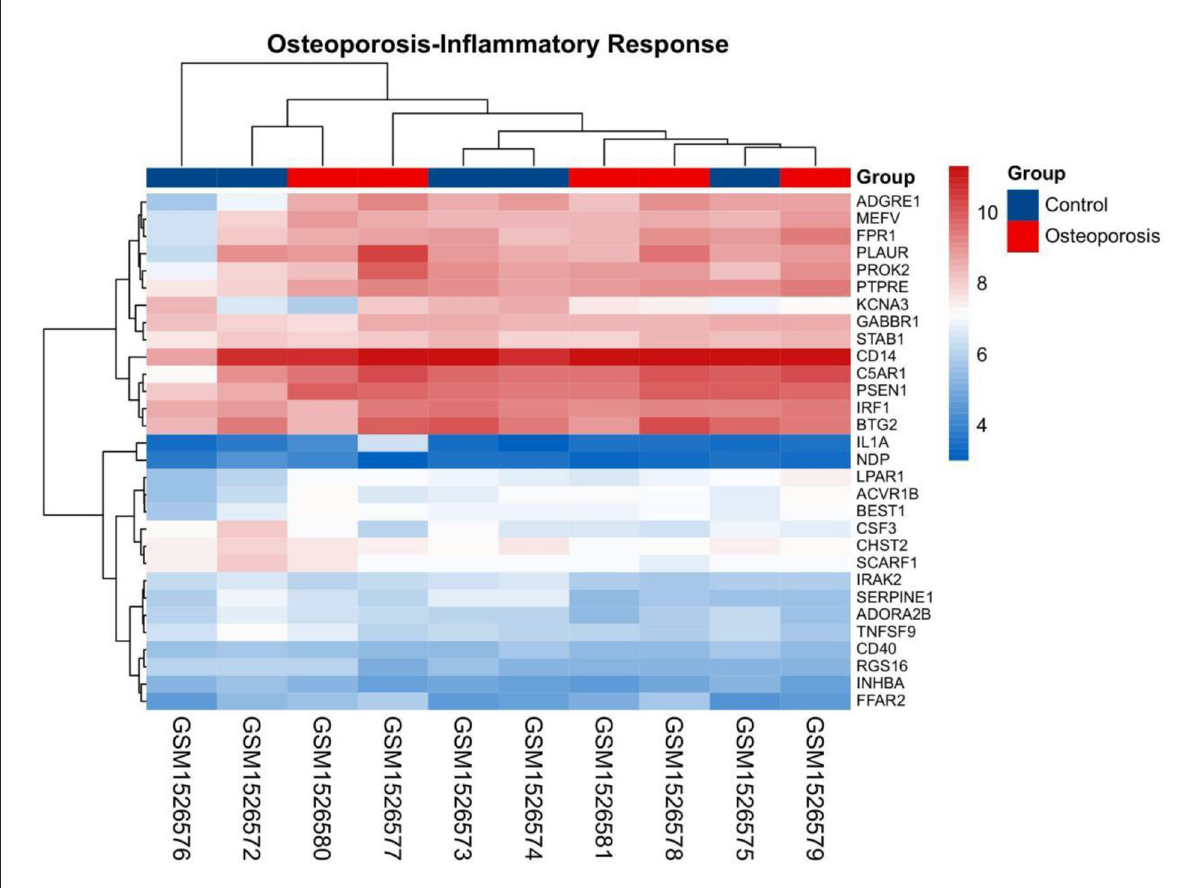
FIGURE6 Heat map for clustering of inflammatory response-related genes in